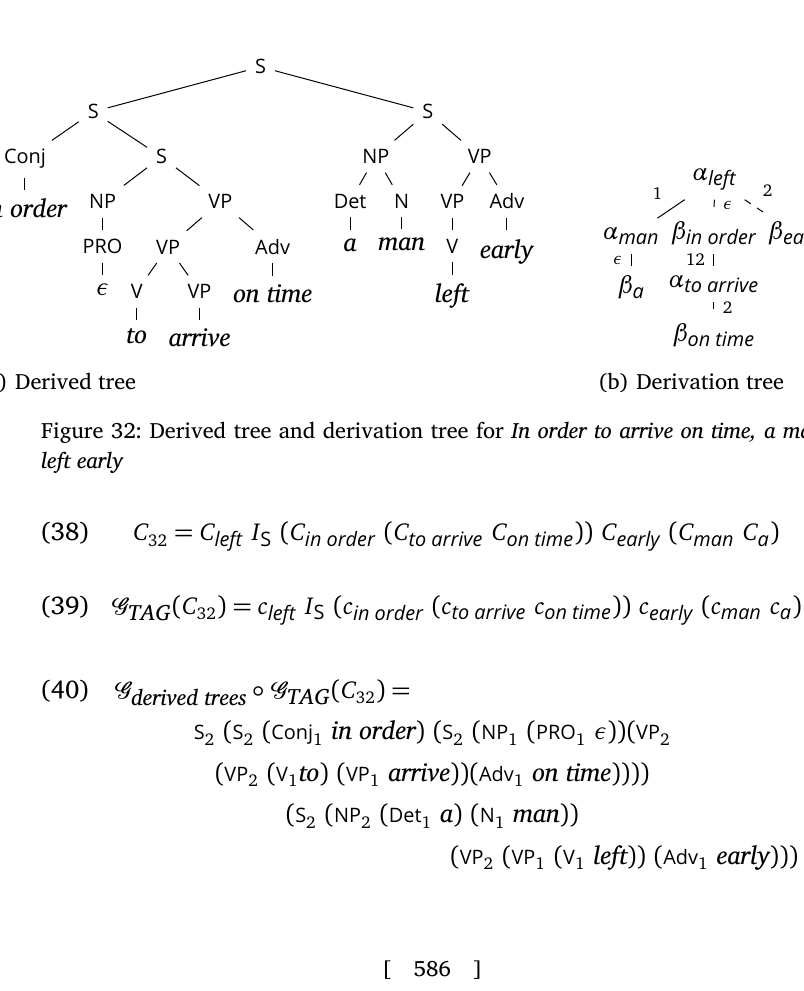
Corresponding elementary tree